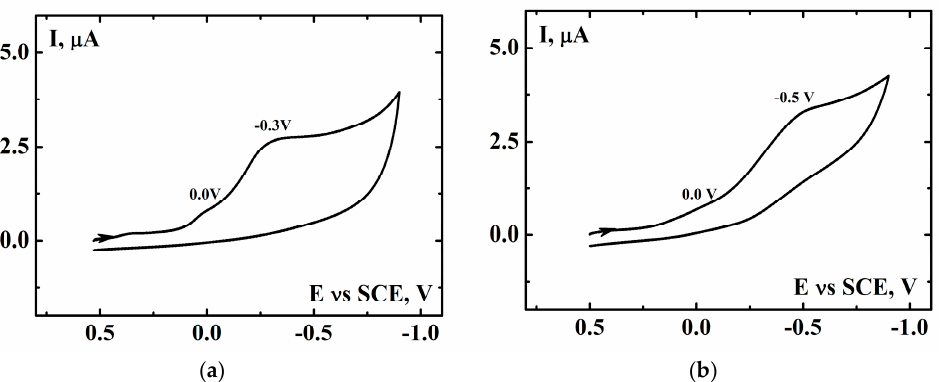
Figure 5. Cyclic voltammograms for 1 mM [(N4Py)Fe II ] 2+ in air atmosphere after 5 h of introduction of ( a ) 1 M cyclohexene and ( b ) 1 M limonene into the system, registered in MeCN [0.1 M ( t -Bu) 4 NClO 4 ]. Scan rate, 0.1 V ∙ s − 1 , GCE (0.008cm 2 ), SCE vs. NHE +0.242 V.